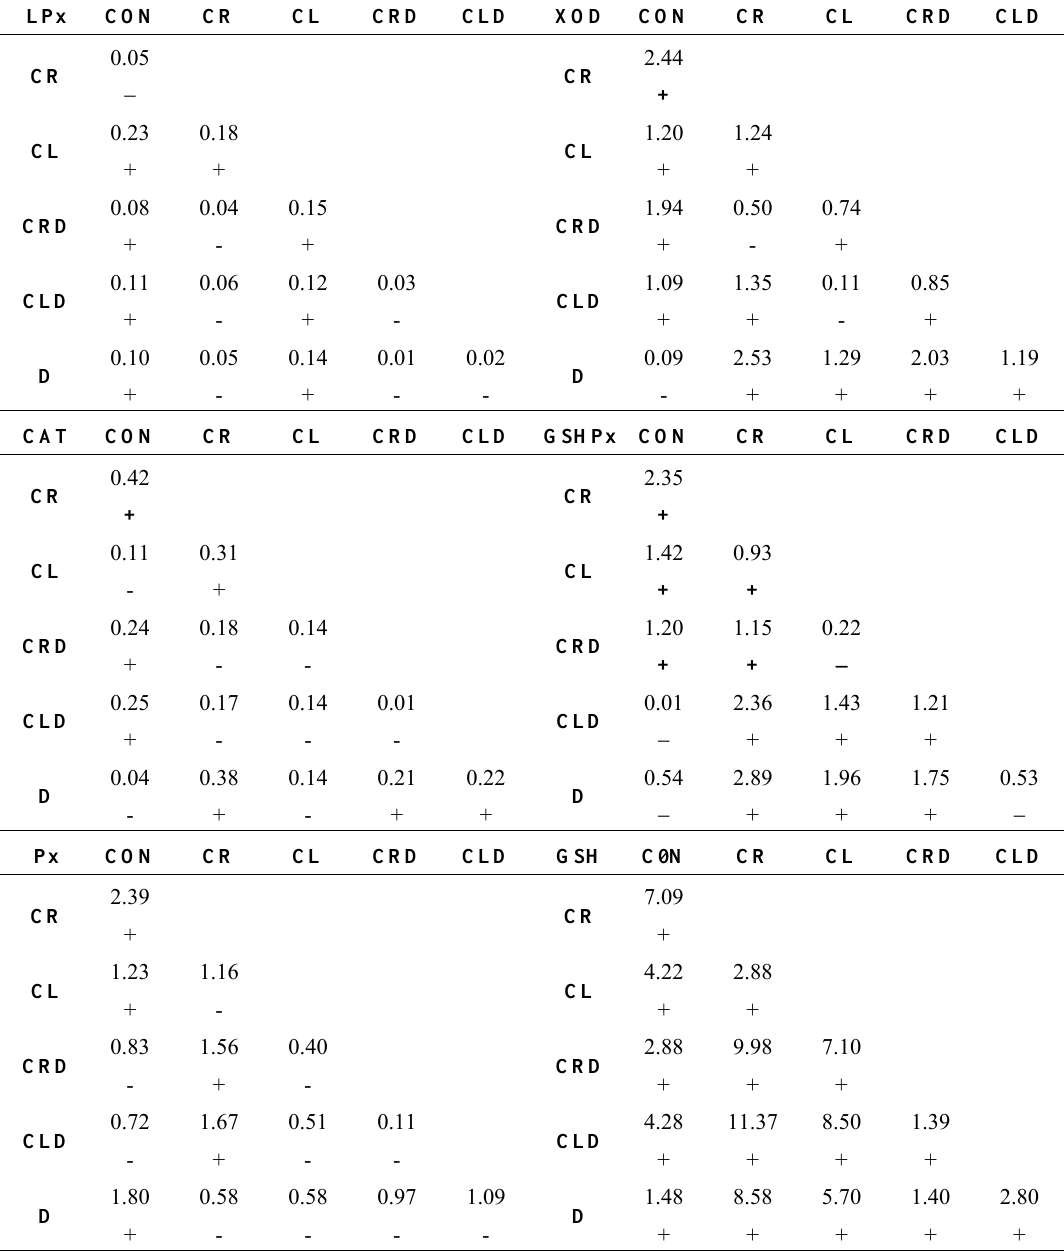
Table 2. ANOVA Test for Biochemical Parameters Analyzed in Liver